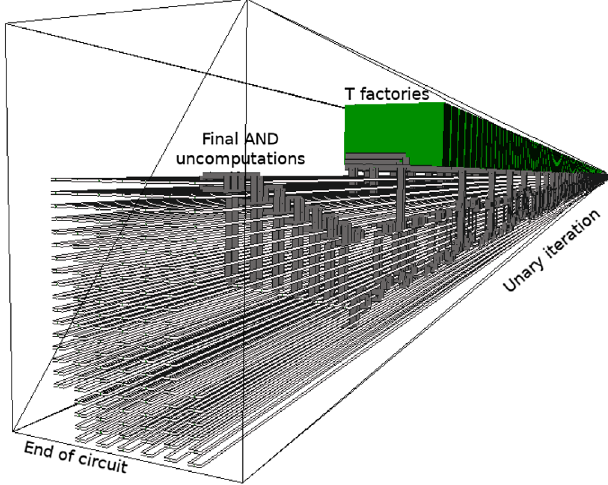
FIG. 25. Illustration of the circuit layout used for resource estimation. The figure shows a portion of a circuit towards the outputs (the time axis indicating circuit execution runs from the back to the front). The figure sketches the arrangement of the logical qubits (light gray lines), the CNOT s (dark gray lines), with the boxes (green) abstracting the multilevel distillation circuits from Fig. 24 and the bounding box (black wire frame) expressing the resources estimated to lay out the circuit.